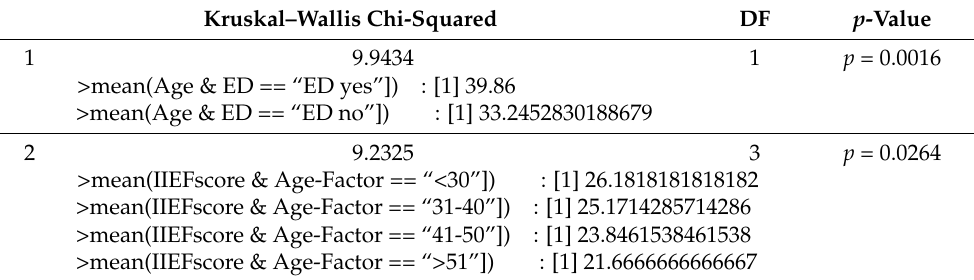
Figure 3. IIEF score (erectile function) distribution by age groups. Table 3. Correlation between age and ED.